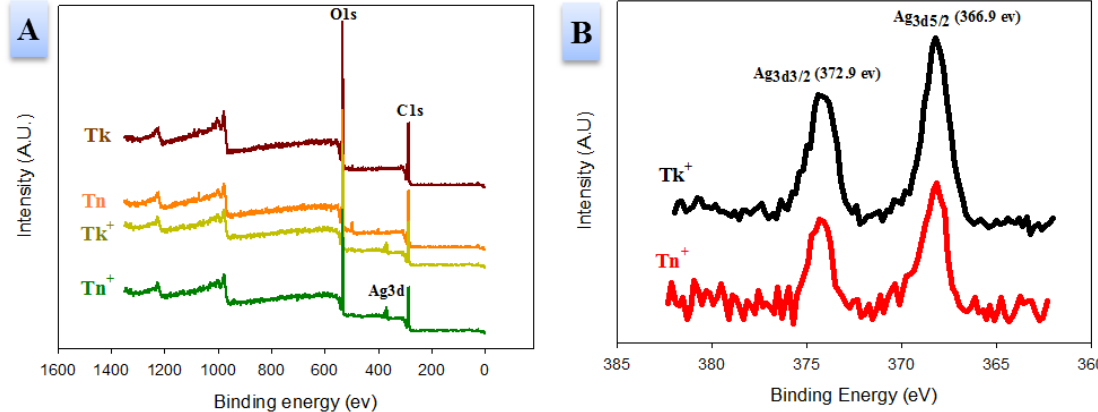
Figure 4. The X-ray photoelectron spectroscopy (XPS) analysis of Tk, Tn, Tk + , and Tn + CSNFMs ( A ) and high resolution XPS spectra of Tk + , and Tn + CSNFMs ( B ). Table 1. The elemental composition from X-ray photoelectron spectroscopy (XPS) analysis.